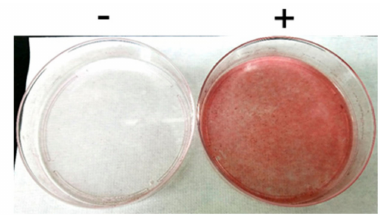
Figure 1. Oil Red O staining of L1-GLUT4 cells. L1-GLUT4 cells before (-) and after ( + ) the induction of in vitro di ff erentiation for 14 days were subjected to Oil Red O